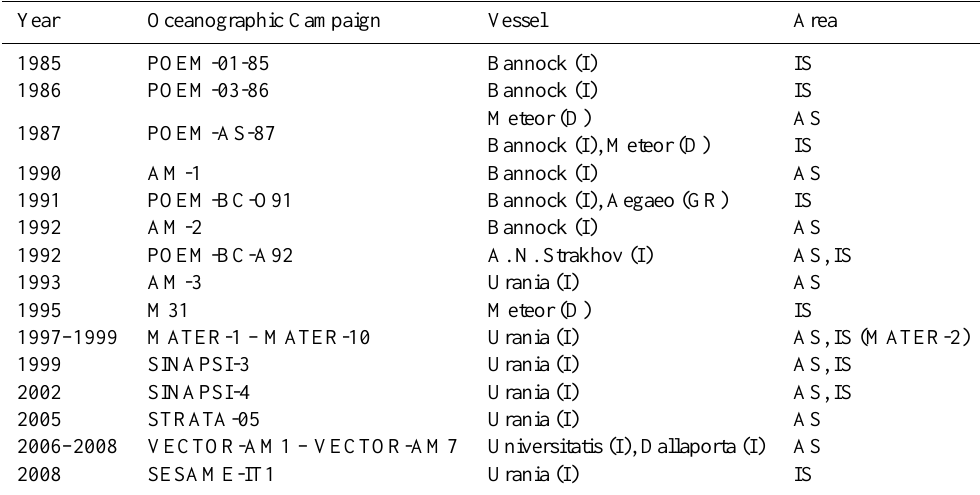
Table 1. Oceanographic campaigns originating the data used in the present